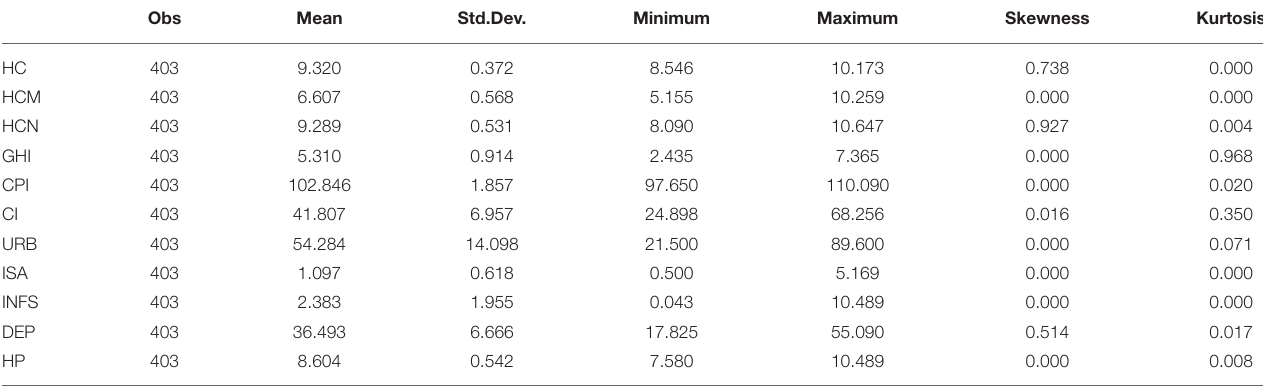
TABLE 1 | Descriptive statistics of the